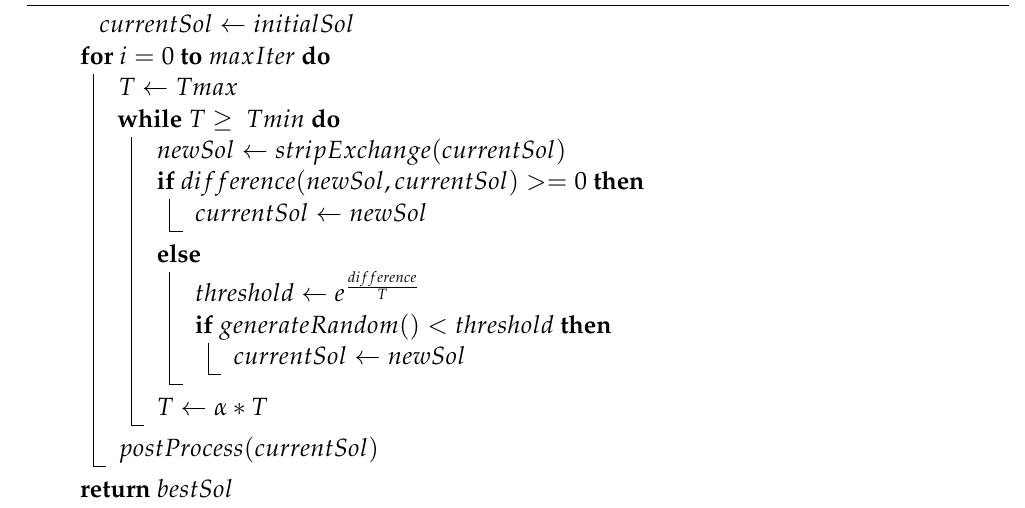
Algorithm 1: Simulated annealing with regroup